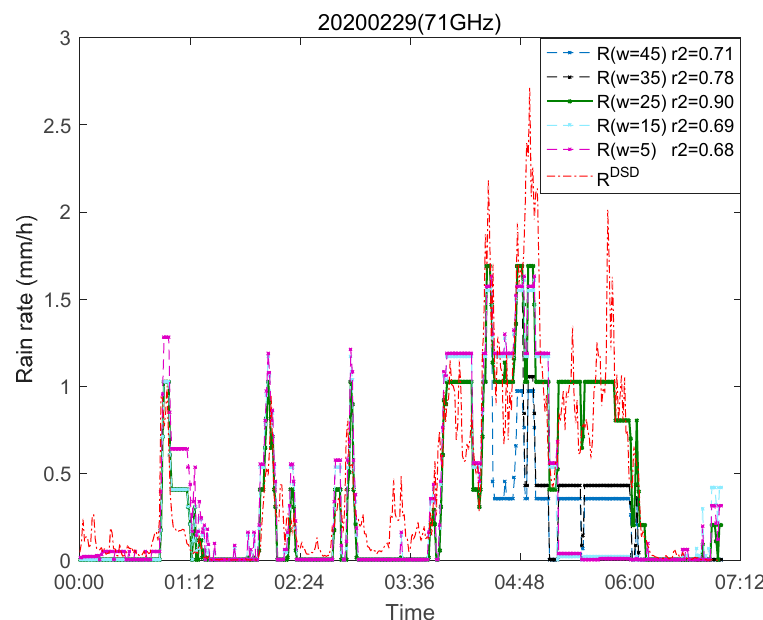
Figure 9. Rainfall rate is retrieved for links in different time windows at 71 GHz on 29 February 2020, and r 2 represents the correlation between R (71 GHz) and R DSD .